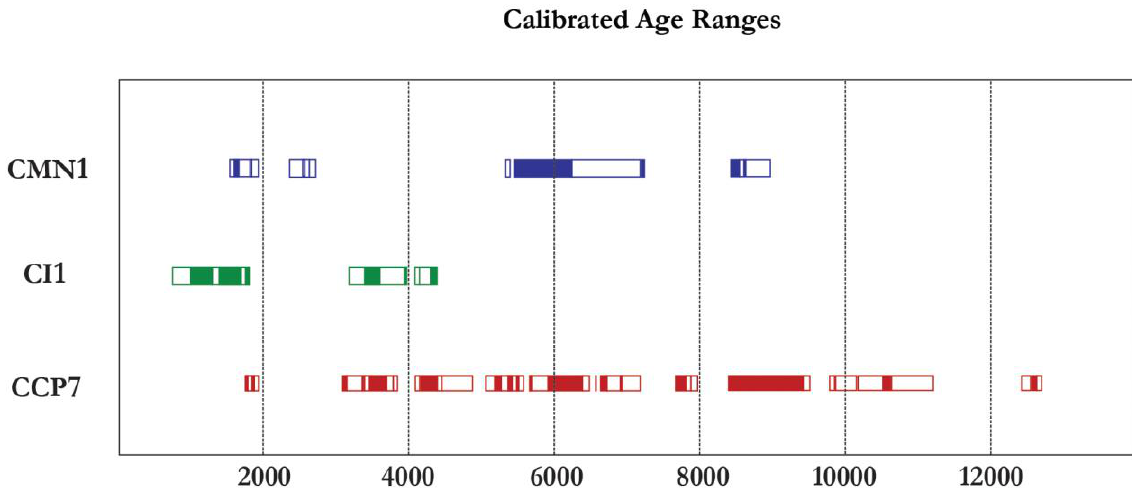
Figure 3. Statistical sum of probabilities for chronological calibrated ranges of CMI1, CI1 and